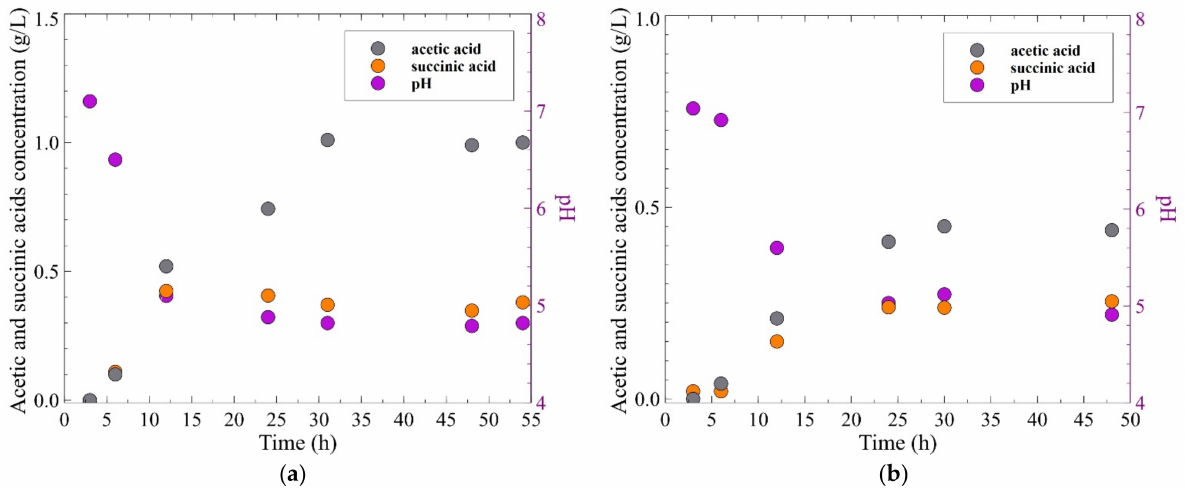
Figure 3. The changes of carboxylic acids concentrations and broth pH during the glycerol fermentation process, under conditions of uncontrolled pH. Initial glycerol concentration: ( a ) 20 g/L; ( b ) 10